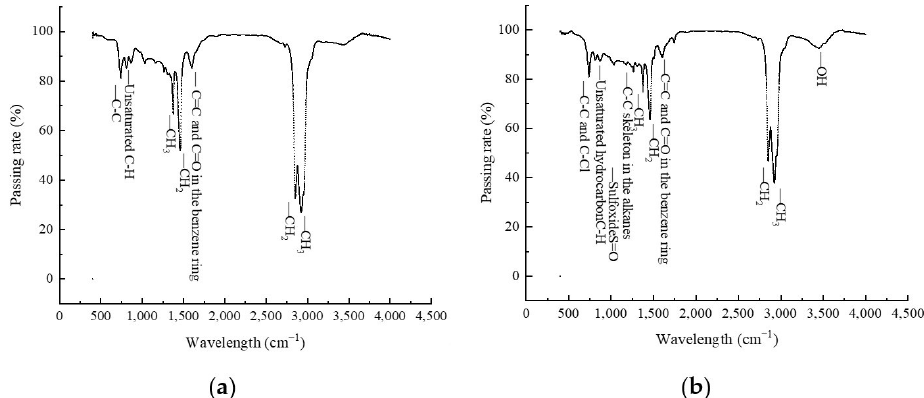
Figure 10. The infrared spectrum of matrix asphalt and PCB-NMF-modified asphalt: ( a ) matrix asphalt; ( b ) PCB-NMF (30%) modified